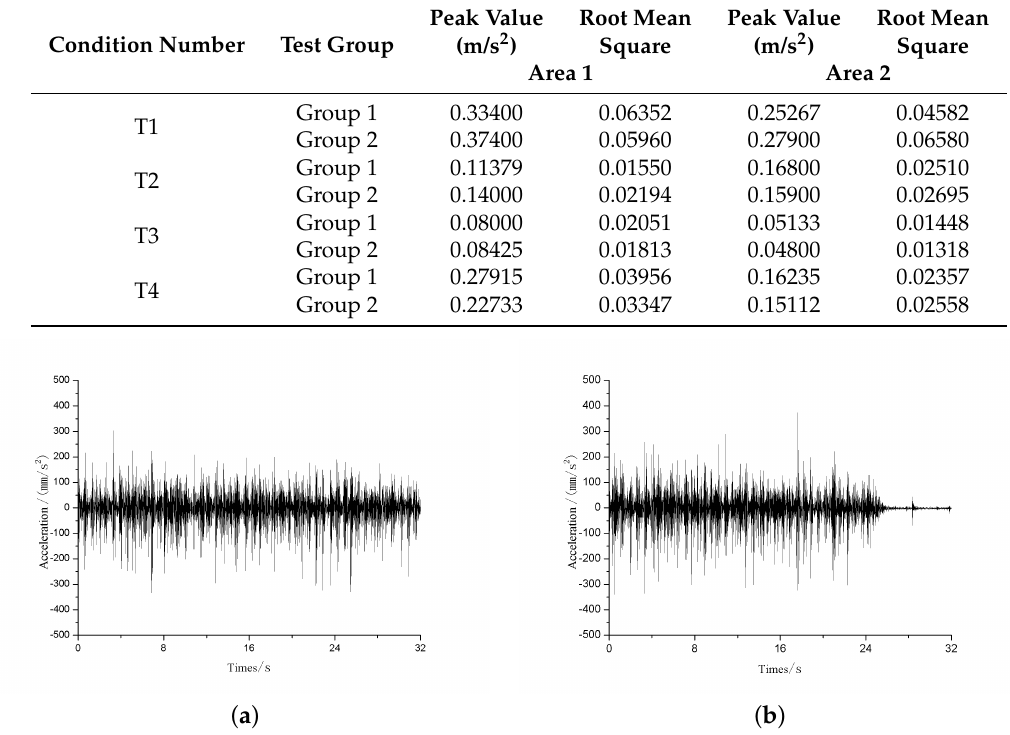
Figure 11. Area 1, maximal response under condition T1. ( a ) Test group 1; ( b ) Test group 2. The theoretical value was consistent with the actual measured value. The position where the acceleration response is larger in the field test is similar to the maximum re- sponse position in the finite element calculation result, and the test value was selected for comparison with the finite-element calculation value of the response (Table 8). Table 8. Theoretical value and maximal value of measured value of the